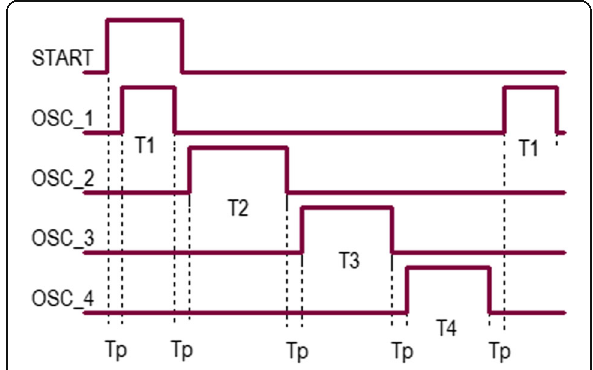
Fig. 2 Oscillator output signals ( OSC _1, OSC _ 2, OSC _3, and OSC _4); T1, T2, T3, and T4 are durations of active states of OSC _1, OSC _2, OSC _3, and OSC _4 signals,